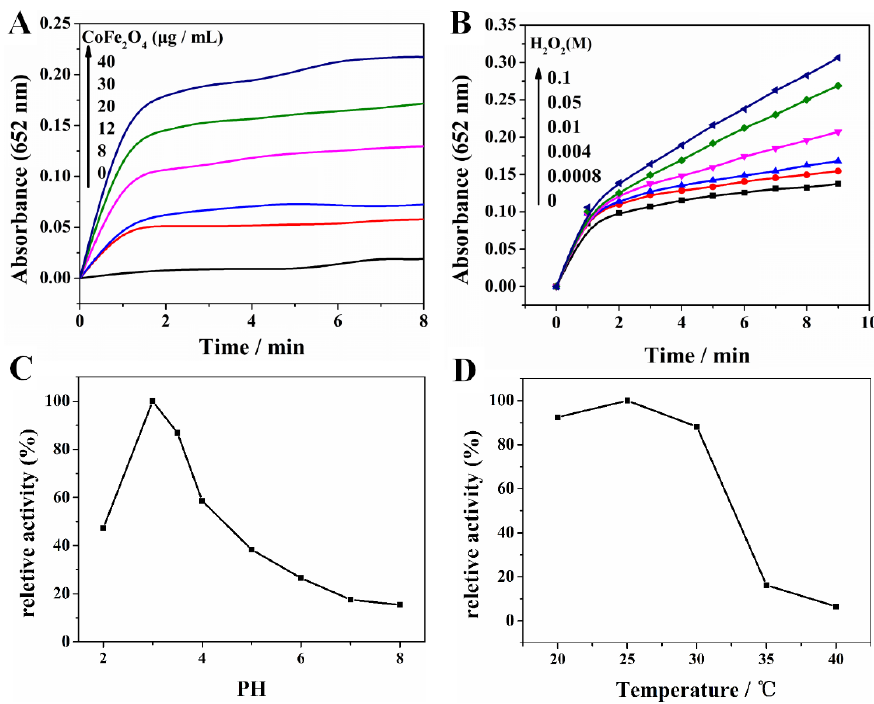
Figure 7. ( A ) Time-dependence absorbance at 652 nm of the 0.08 mM TMB reaction solution in the absence or presence of different doses of CF300 in 20 mM PBS (pH = 3.0) with 0.8 mM H 2 O 2 at room temperature. ( B ) Time-dependence absorbance at 652 nm of the 0.4 mM TMB reaction solution in